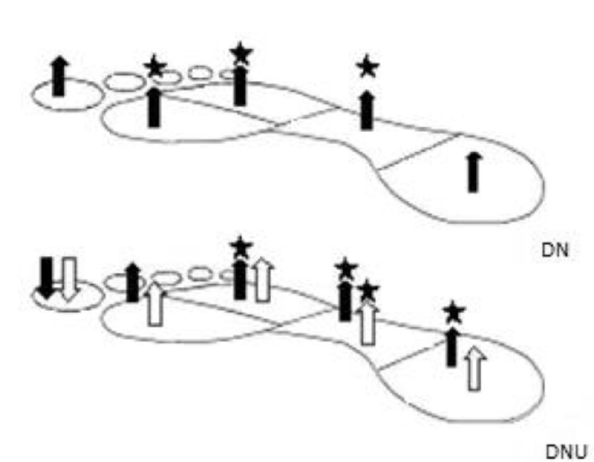
Figure 2 – Summary of differences in pressure-time integral according to its tendency. Upper panel presentation: comparison between DN and CG (black arrows), showing higher values for DN. Lower panel: comparison between DNU and CG (black arrows) and to DN (white arrows). Black stars represent significant differences (p<0.05) between